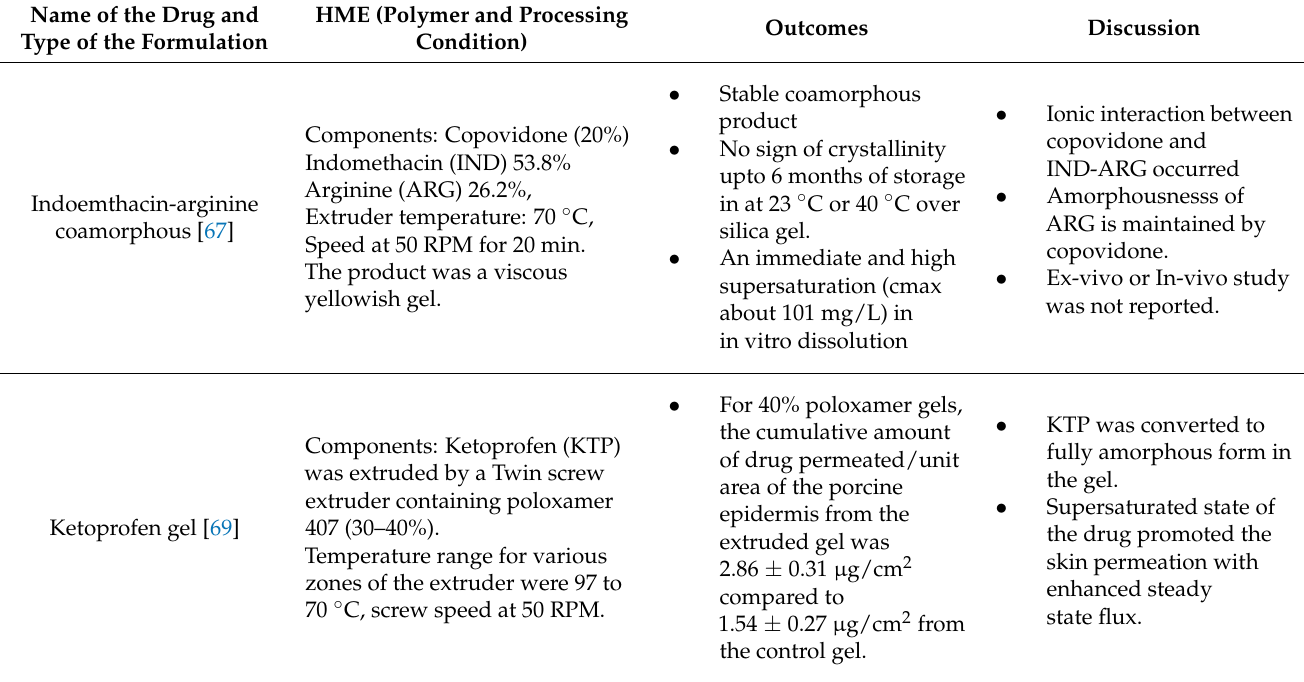
Table 2. Transdermal amorphous drug-loaded delivery system formulated by